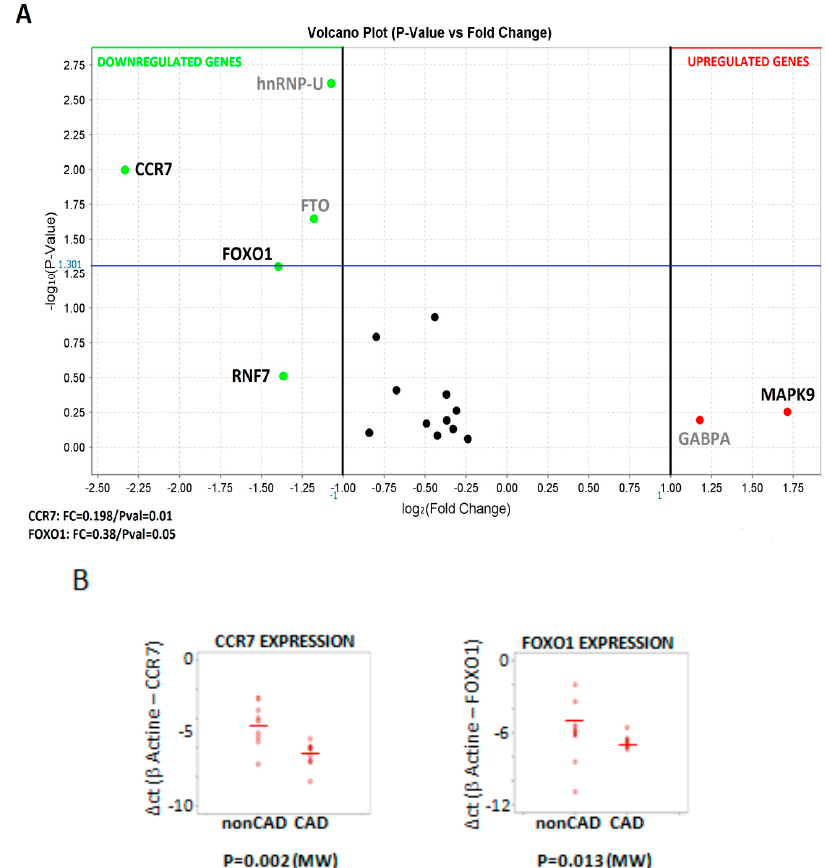
Figure 4. ( A ) Volcano plot (log 2 Fold Change vs. -log 10 ( p -Value)) of the expression of the 14 validated Oxtress mRNAs in PBMCs of ATH patients. Colored dots identify upregulated genes (represented as red dots) or downregulated genes (green dots). The blue line indicates statistical significance. Gene Symbols in bold black indicate genes from this study while those in grey belonging to other study and will be published elsewhere. ( B ) Scatter Plot of CCR7 and FOXO1 expression in PBMNCs from patients with CAD and normal controls without CAD. The mean value and the p value are marked. p value was calculated with the nonparametric Mann-Whitney U test.